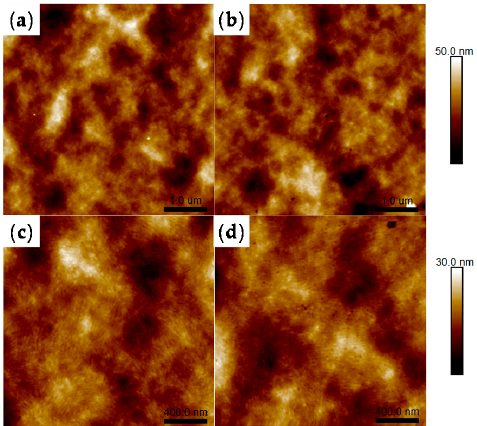
Figure 3. Atomic Force Microscope (AFM) height images of ( a , c ) P3HT:PC 61 BM and ( b , d ) PSBMA@P3HT:PC 61 BM. Here the thickness of PSBMA was 5.6 nm. The scanning areas of ( a , b ) and ( c , d ) are 5 × 5 μ m 2 and 2 × 2 μ m 2 , respectively.